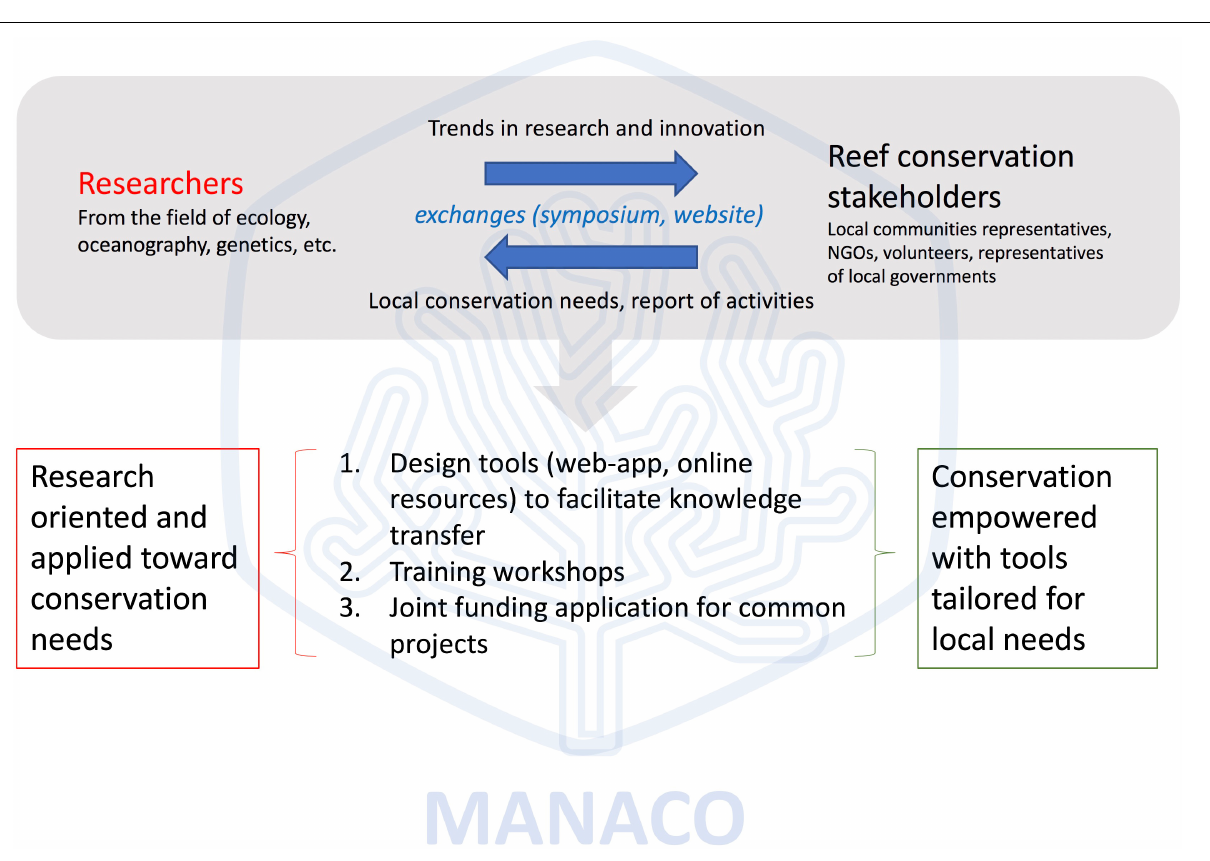
FIGURE 2 | Schematic view of the ManaCo plan of action. The plan of action is composed of two phases. During the first phase (gray box), the discussion between reef conservation stakeholders and researchers aims to identify a specific research topic addressing a precise conservation issue. In the second phase (under the gray box), a strategy is established to facilitate the inherent transfer of knowledge. The instruments used in this phase are the design of tools using recent technologies (web-app, online resources), training workshops or the application for joint funding. The expected benefits for researchers and reef conservation stakeholders are described in the red and green boxes,